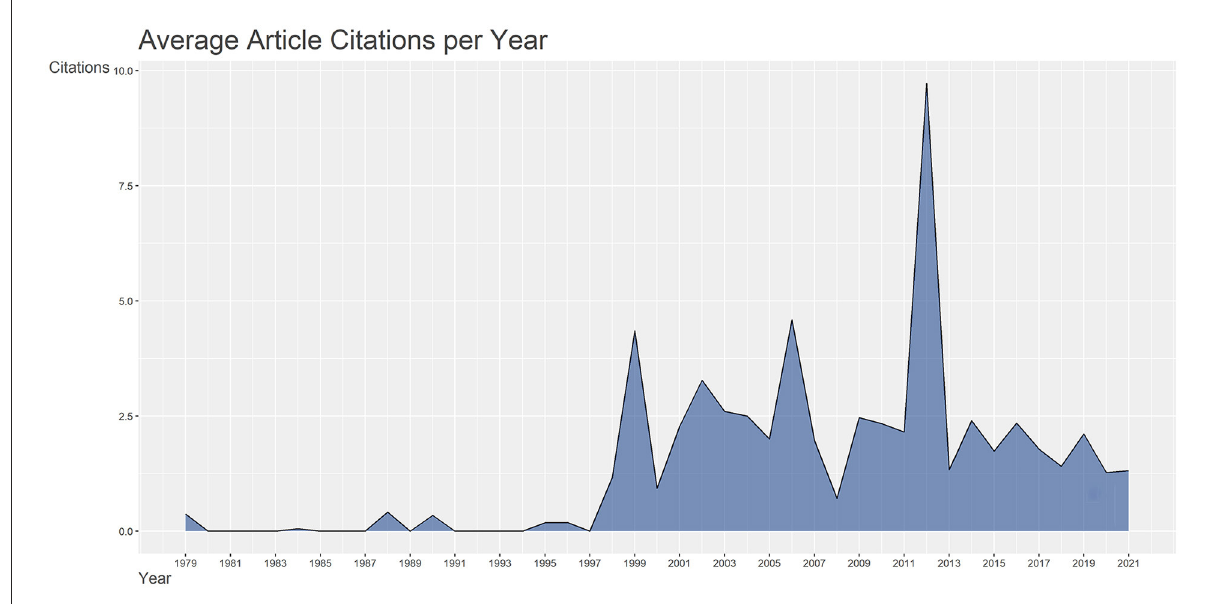
FIGURE2 1979–2021 Average article citations per year in the field of acupuncture for SCI.